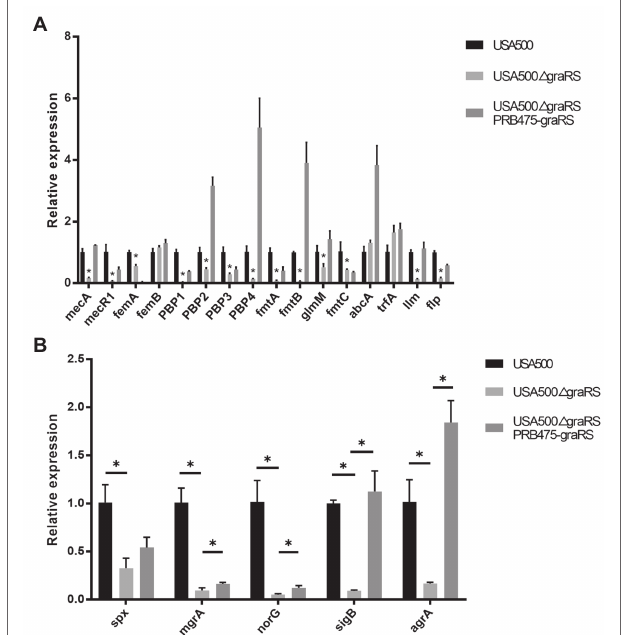
FIGURE 3 | The effect of graRS knockout on the mRNA levels of the antibiotic resistance-related genes. The mRNA of the USA500WT, USA500 Δ graRS , and USA500 Δ graRS:: pRB475- graRS strains cultured in TSB at 4 h was extracted, then qRT-PCR was performed to detected the mRNA levels of β -lactam resistance-related genes (A) and the antibiotic resistance-related global regulatory genes (B)